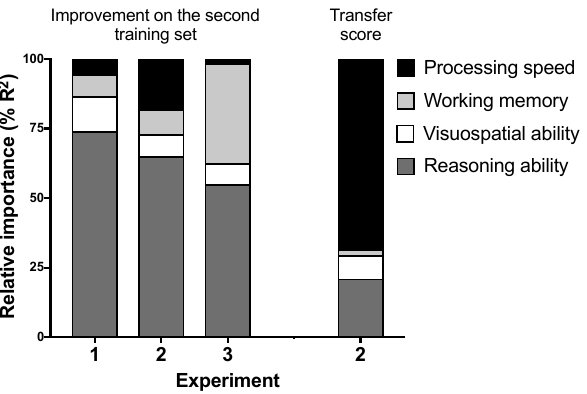
Figure 4. Relative importance metrics for the four fluid abilities obtained from relative importance regression models that included the four fluid abilities as predictors of either the improvement on the second training set (first three bars) or the transfer scores in Experiment 2 (fourth bar).